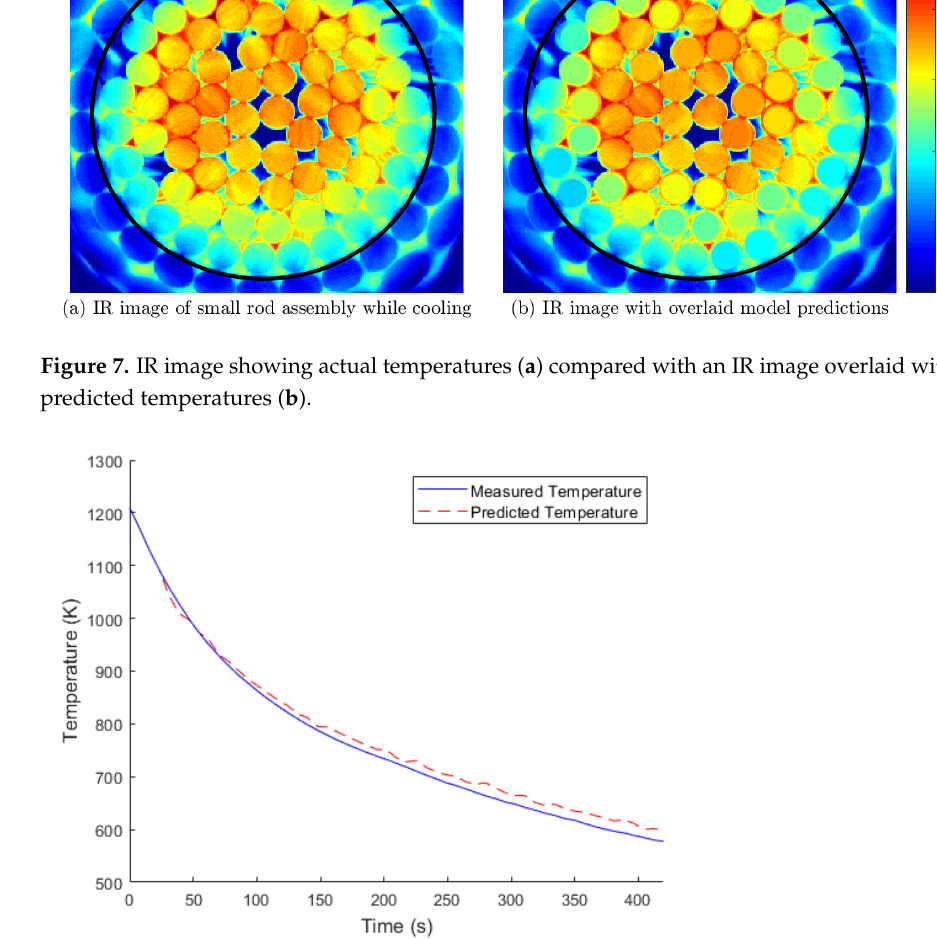
Figure 8. Comparison of measured temperature and SVR predicted temperature for the rod with the greatest error in the 68-rod assembly.